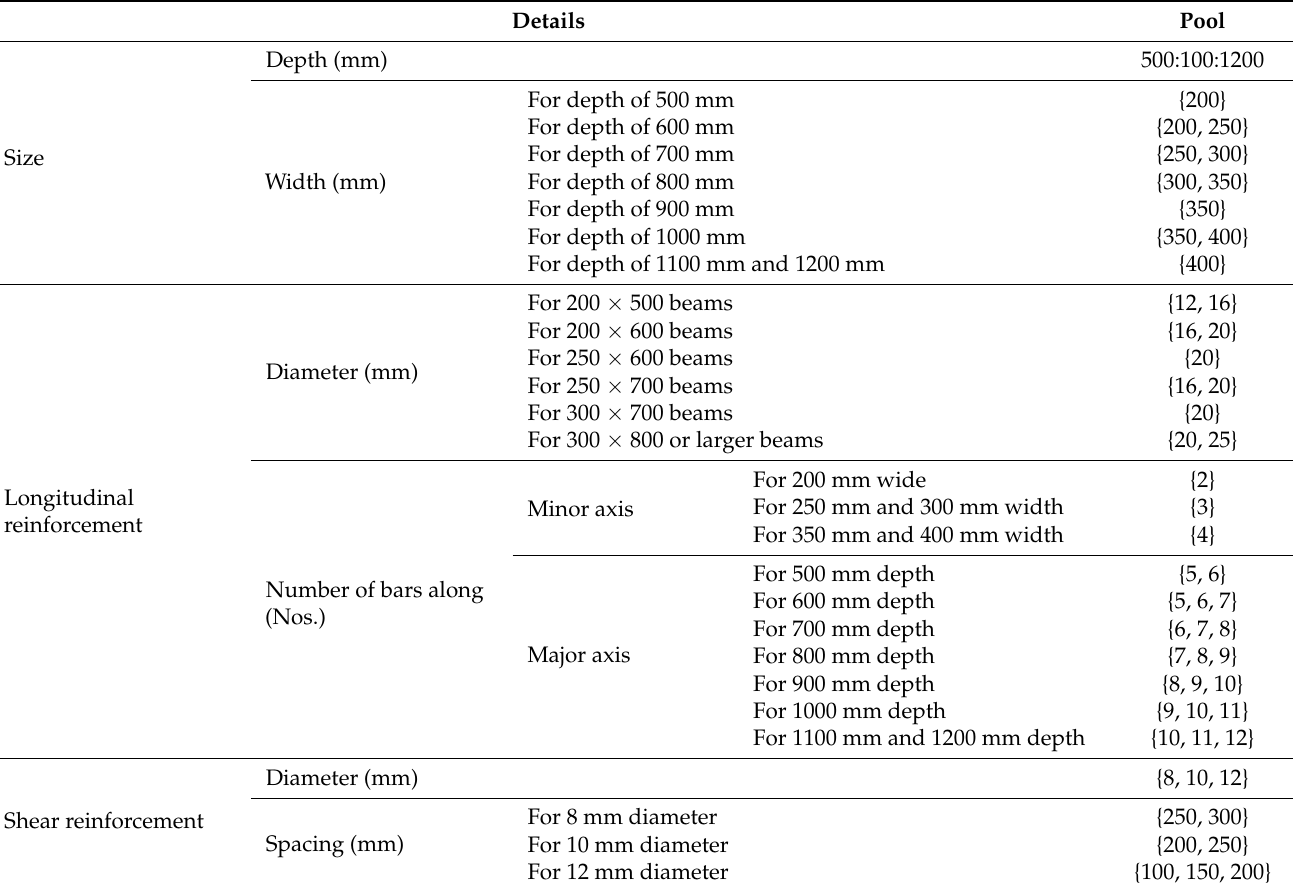
Table 3. Design pools of edge and internal beam variables.